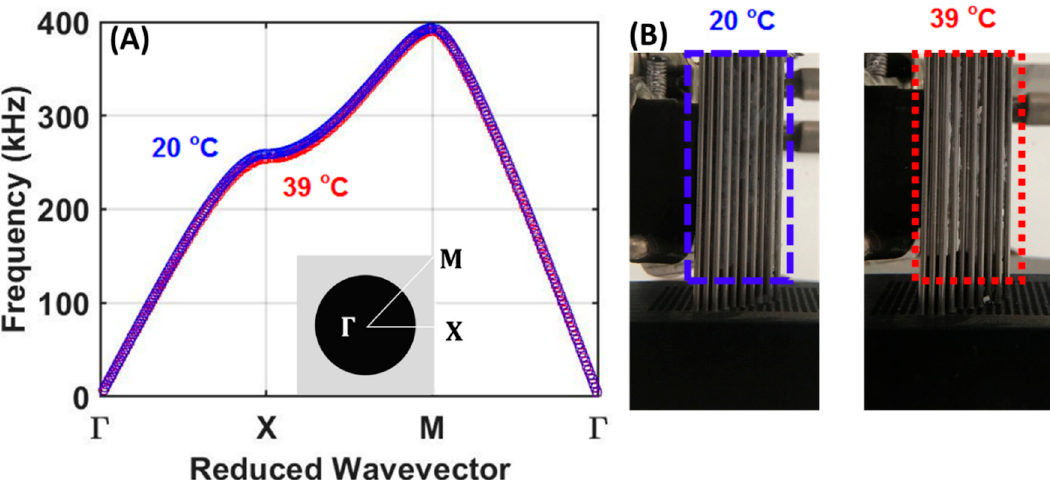
Figure 6. ( A ) Band structure of the first band of the PVA-PNIPAm filled phononic crystal at 20 °C (blue) and 39 °C (red) using the measured hydrogel density and speed of sound. Γ , X , and M points refer to the location of (0,0), (0,1) and (1,1) in the unit reciprocal unit cell. ( B ) Photographs of the TSSL at 20 °C and 39 °C ambient temperatures.